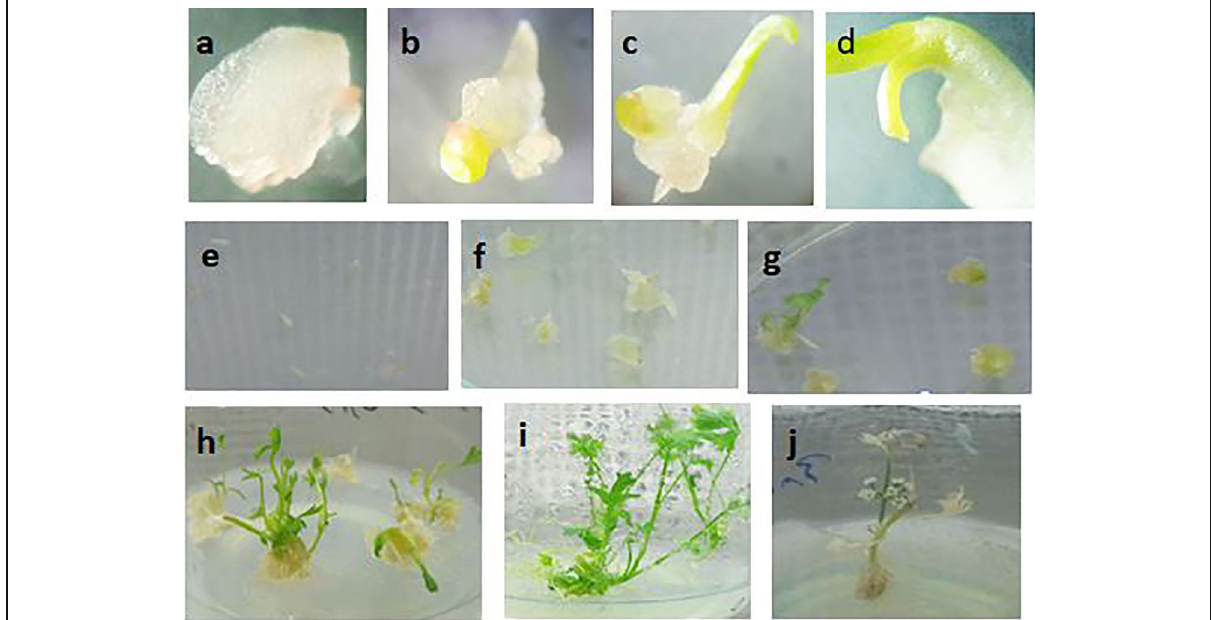
Fig. 1 In vitro regeneration of Trachyspermum ammi using zygotic embryos. a Callus formation. b Callus development. c Monopolar regeneration. d Leaf emergence. e Isolated embryo on B5 media supplemented with 0.5 mg/l BA and 1 mg/l NAA. f Callus induction from mature embryos. g Shoot regeneration from an embryo-derived callus. h Elongation of shoot and root. i Regenerated plantlet from the zygotic embryo. and j The appearance of the